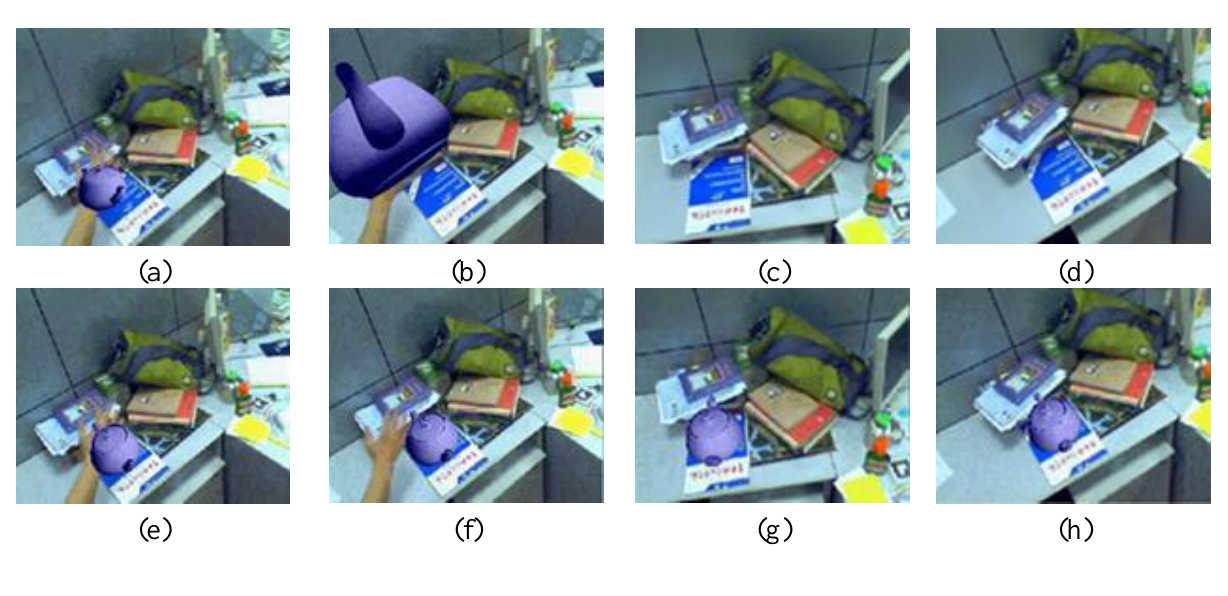
Figure 11. Comparison with KLT and projective reconstruction based method.